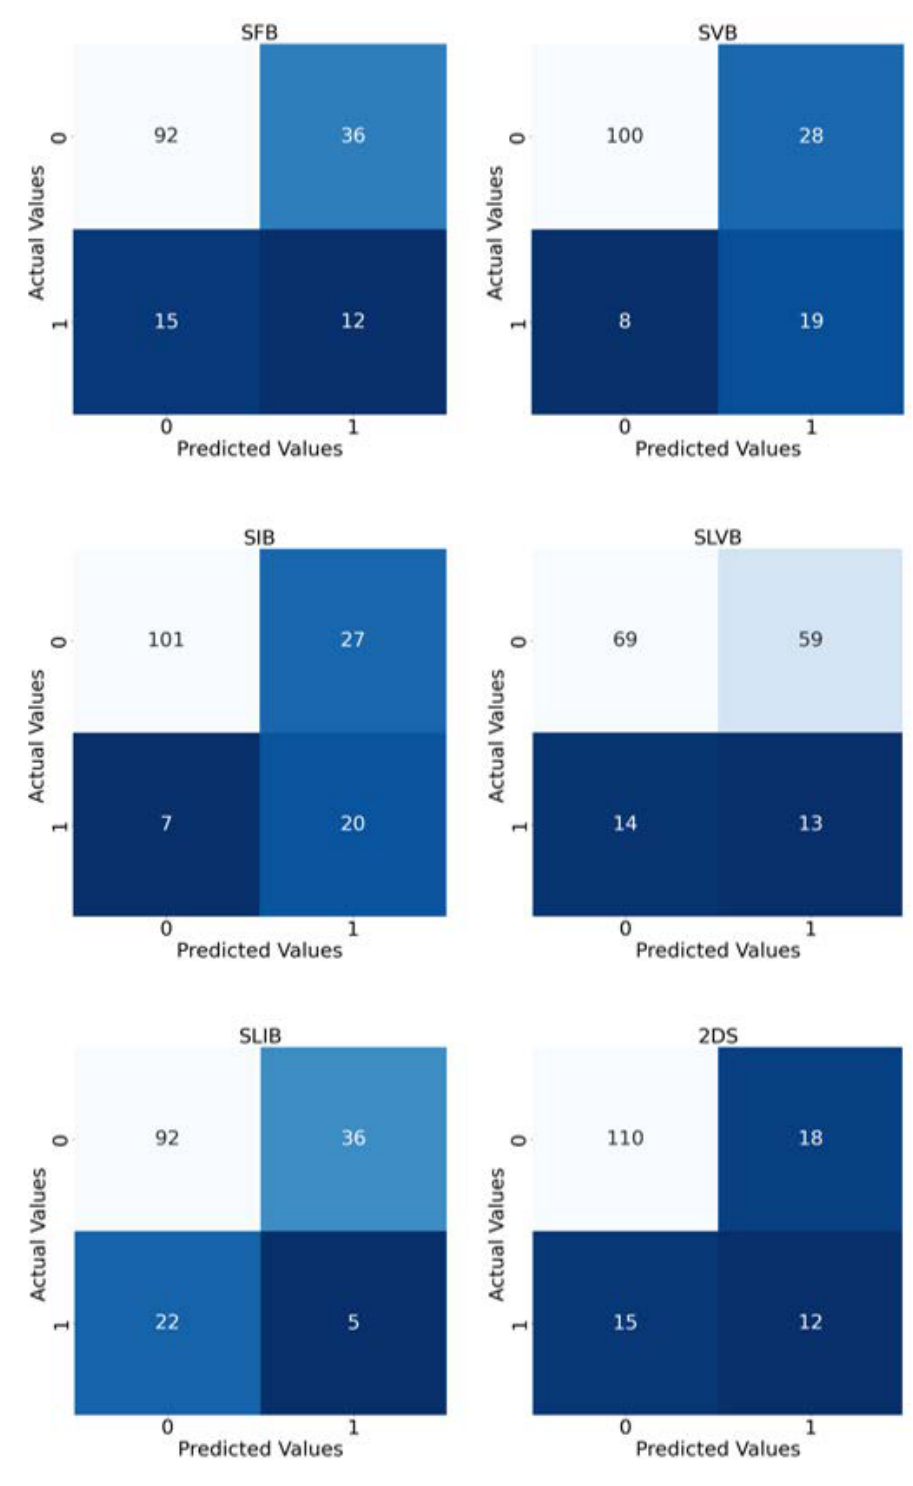
Figure 7. Confusion matrices of the implemented experiments. The title of each matrix suggests the tumor bounding option that is used. In order to have a matrix for each experiment, we merged the predictions of the 10 folds considered as test sets. The colour depends on the number inside the square: the higher the number, the lighter the colour.